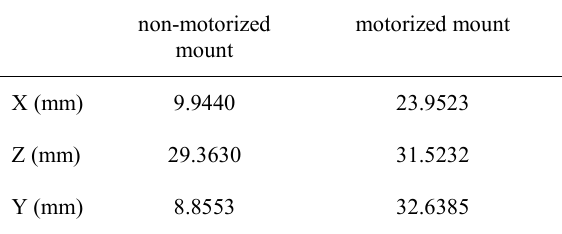
Table 1. The correction shifts of the camera found by the calibration algorithm. The X and Z shifts move the projection centre of the camera at the top of the vertical rotation axis and the Y shift aligns it with the horizontal rotation axis.